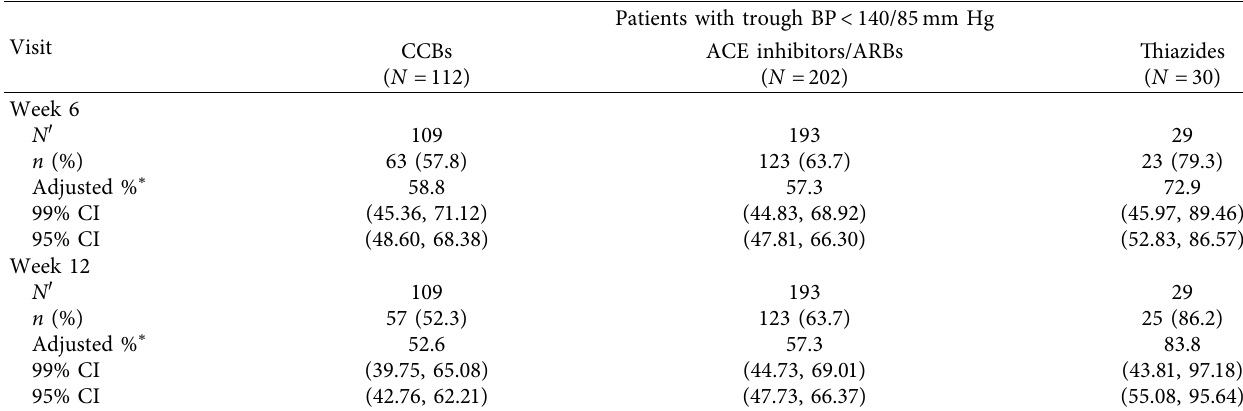
Table 3: Percentage of patients treated with CCBs, ACE/ARBs, and thiazides before baseline 215 reaching BP < 140/85mm Hg using GEE (logistic regression model): FAS and LOCF.